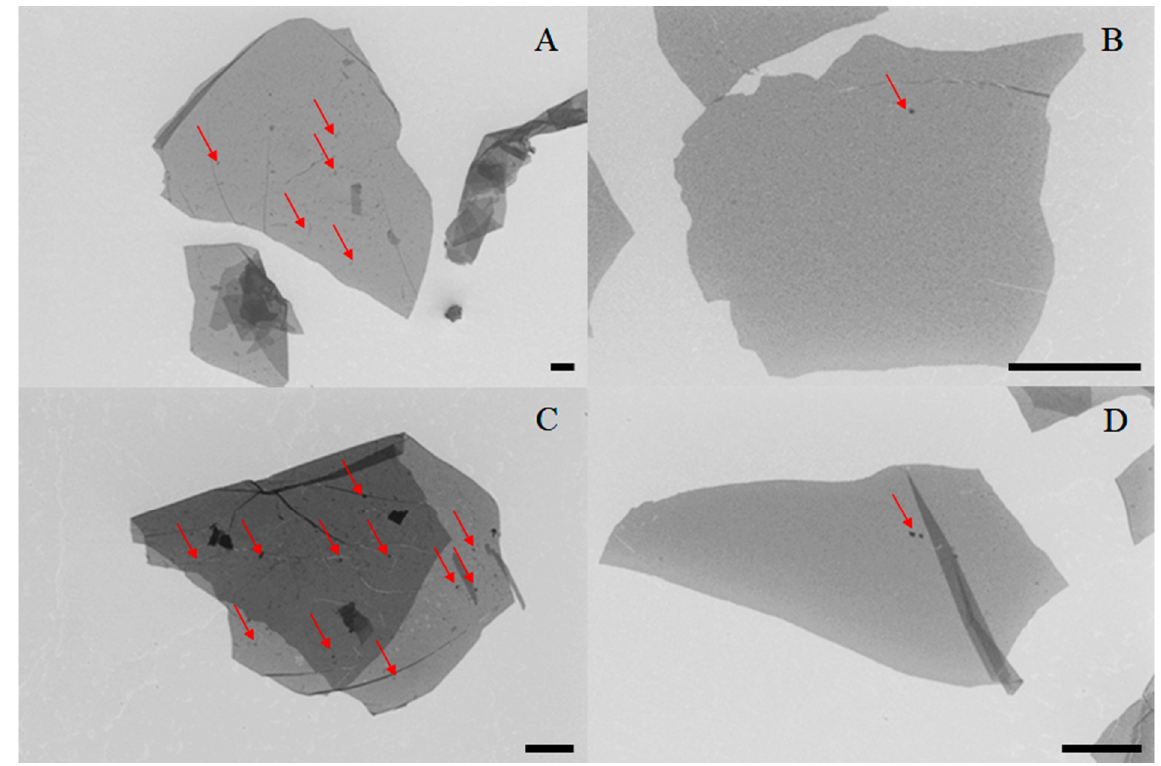
Figure 2. SEM images of graphene oxide flakes: ( A ) as-obtained, ( B ) purified, ( C ) aged_as-obtained, ( D ) aged_purified. Scalebar normalized to 2 μ m. The red arrows indicate impurities on the flakes’ surface.